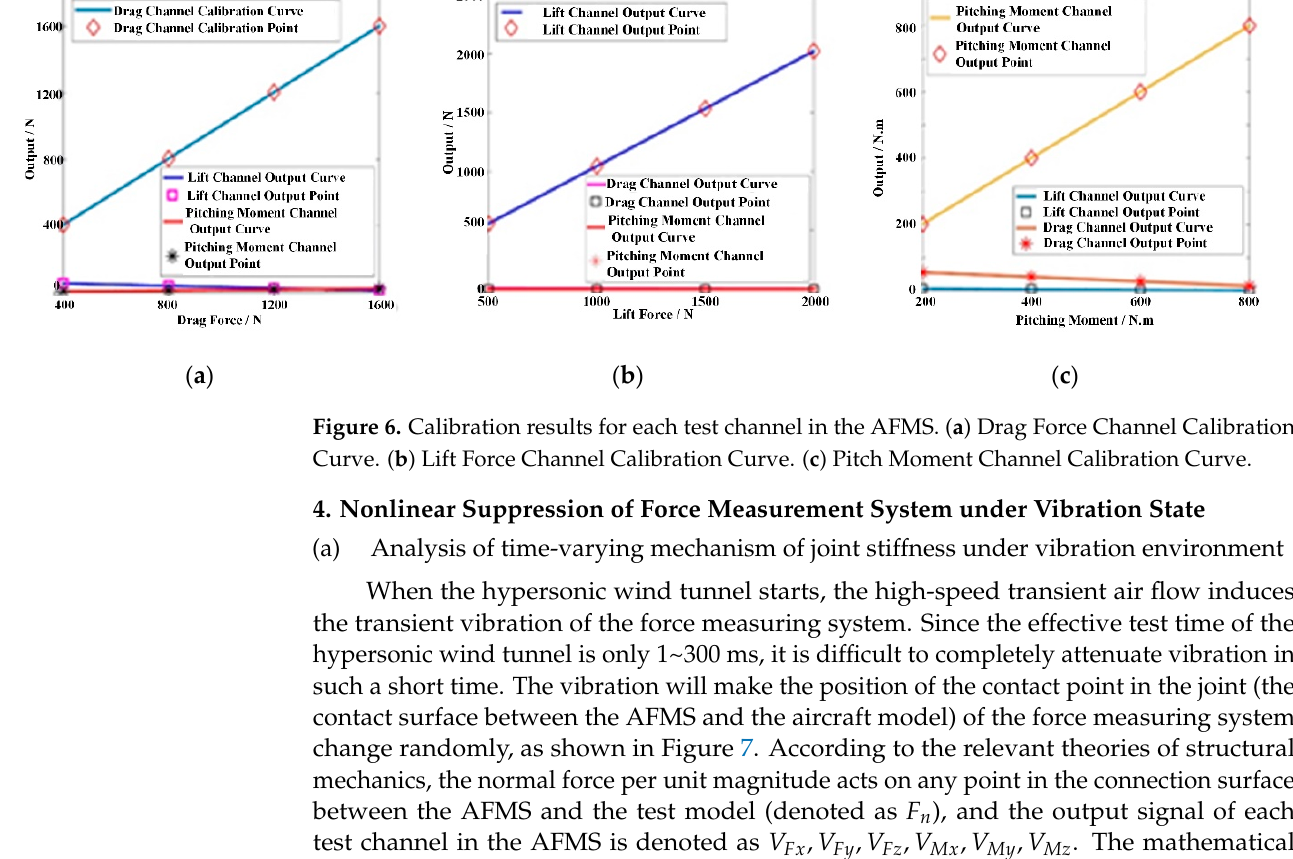
Figure 6. Calibration results for each test channel in the AFMS. ( a ) Drag Force Channel Calibration